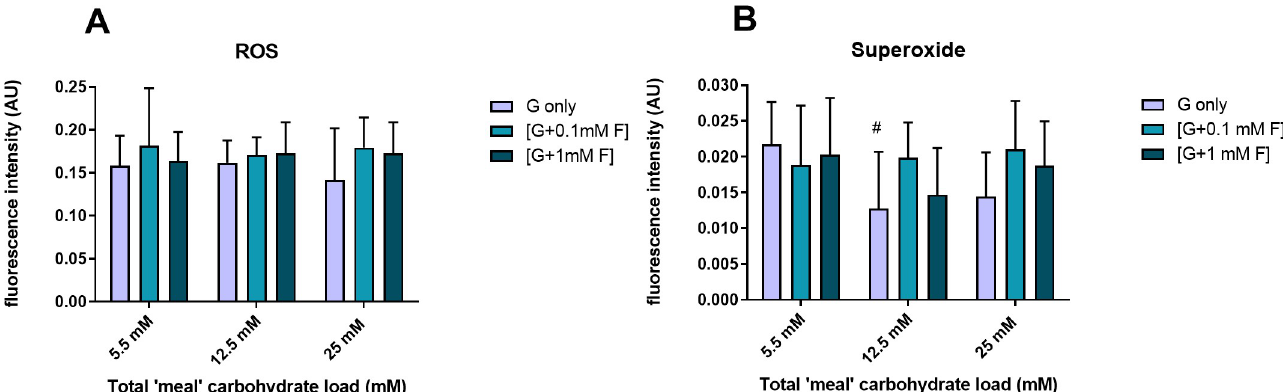
Fig 5. ROS generation. Effect of intermittent glucose and glucose/fructose exposure on total ROS-RNS (A) and superoxide (B; n = 7–12; #P < 0.05 compared to 5.5 mM glucose alone).